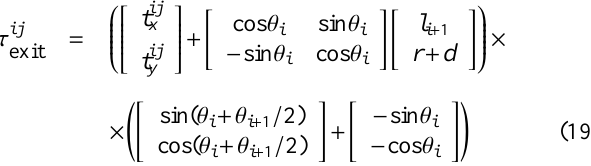
Through a similar computation, using the notation from Figs. 4 and A1, we can compute the torque applied at the tendon exit point from link i